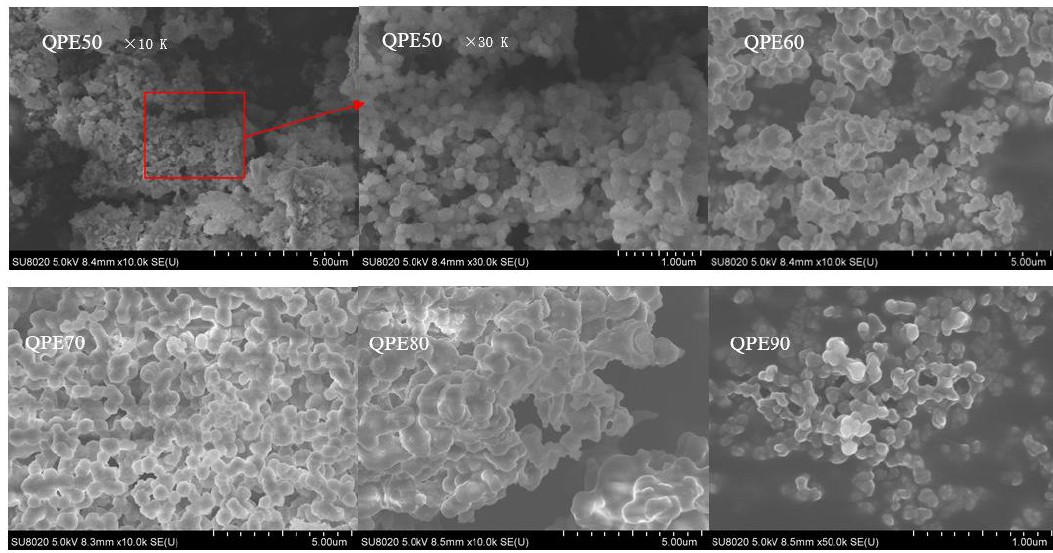
Figure 4. SEM images of QPs.